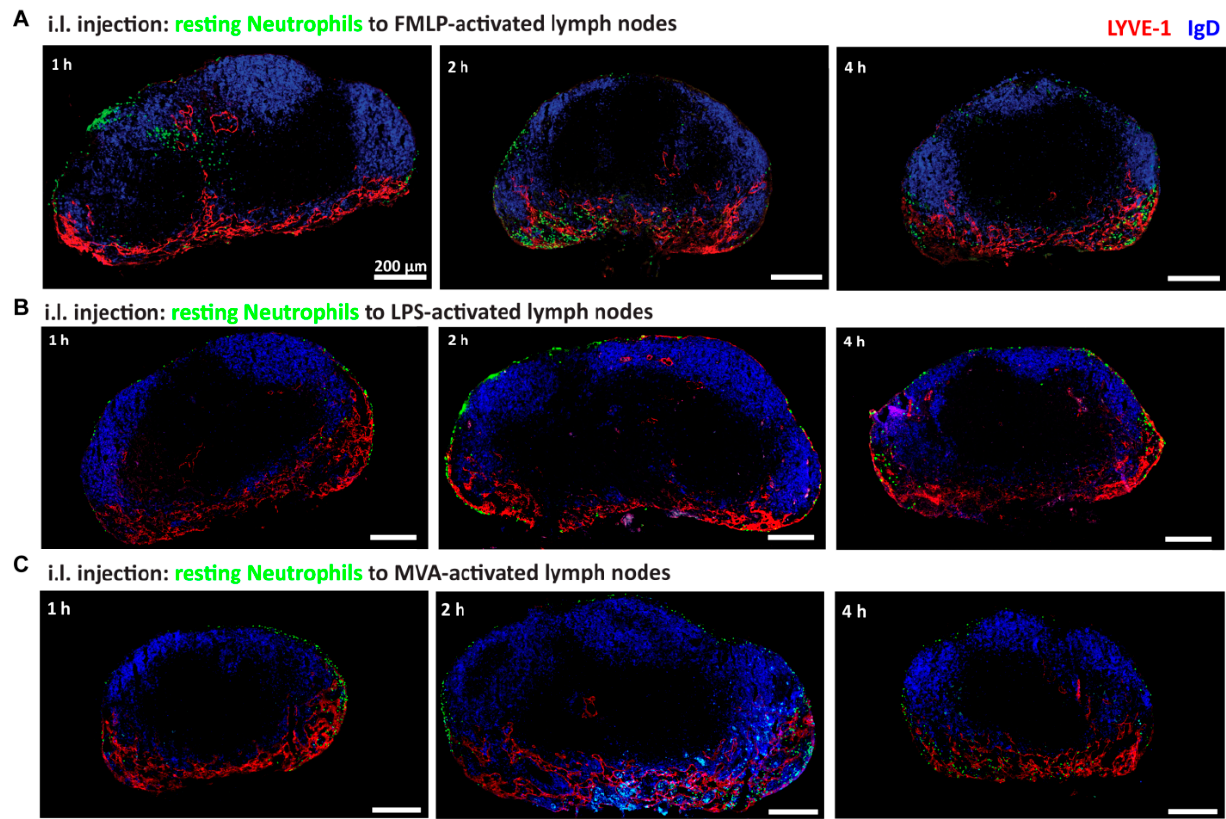
Figure 2. Positioning of resting neutrophils in activated lymph nodes. ( A ) Cryosectioned, fMLP–activated popliteal lymph nodes 1 to 4 h after intra-lymphatic transfer of resting neutrophils (green) are shown. Histological staining with anti-LYVE-1 (red) and anti-IgD (blue). Scale bar 200 µm. For all time points investigated a total of 12 lymph nodes was analyzed. ( B ) Fixed cryosections of LPS–activated (1 day) popliteal lymph nodes 1 to 4 h after i.l. transfer of neutrophils (green), stained with antibodies against LYVE-1 (red) and IgD (blue) are shown. Scale bar 200 µm. For all time points a total of 6 lymph nodes was analyzed. ( C ) Lymph node cryosections show MVA-infected (4 h p.i.) lymph nodes 1 to 4 h post i.l. transfer of neutrophils (green). All sections were stained using anti-LYVE-1 (red) and anti-IgD (blue) antibodies. Scale bar 200 µm. Representative data from 5 analyzed lymph nodes are shown.